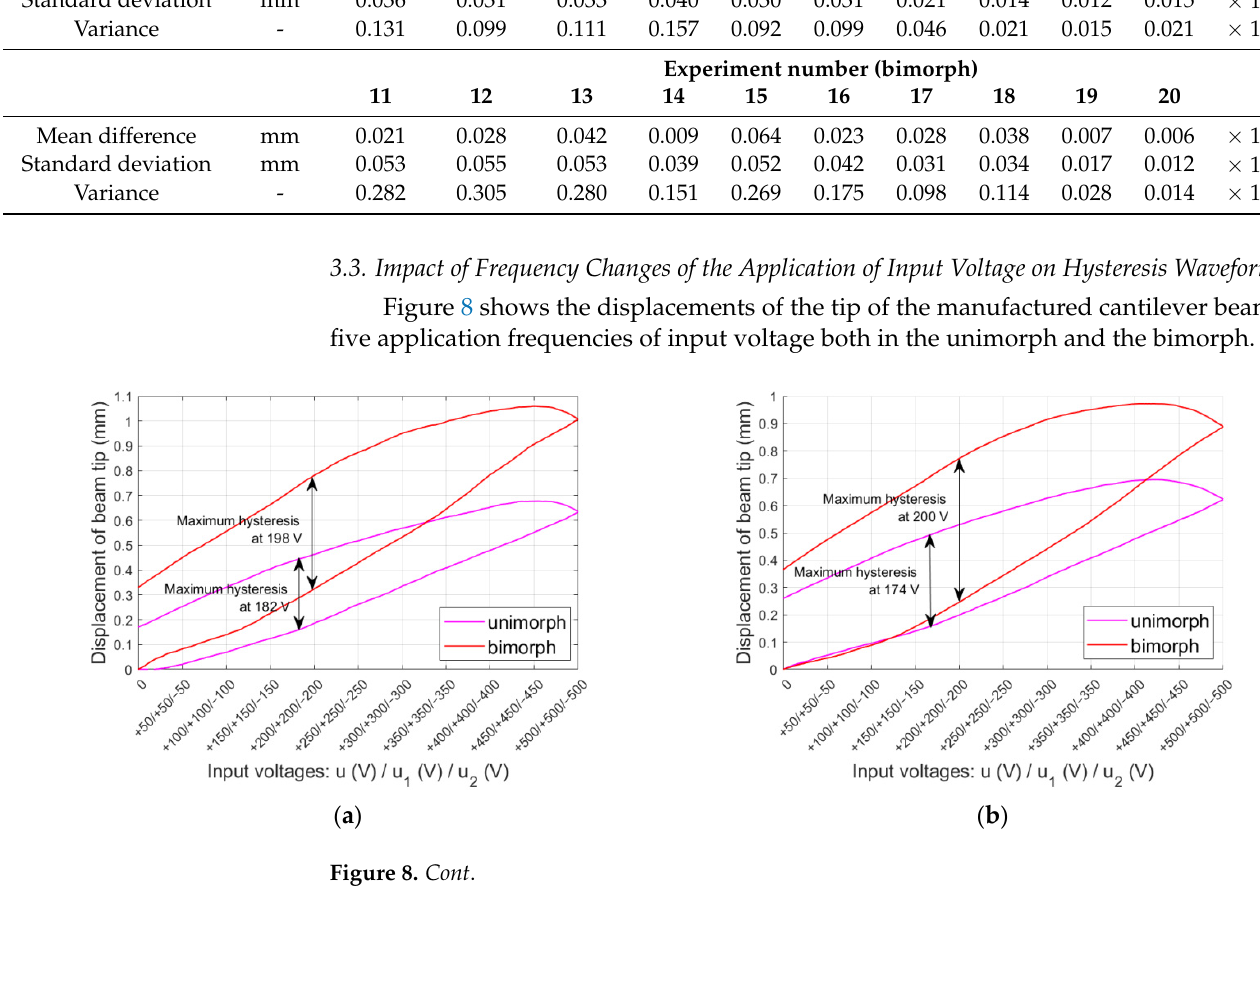
( d ) ( e ) Figure 8. Hysteresis loops in a unimorph and bimorph for u max = +500 V and u 1max = +500 V, u 2max = – 500 V: ( a ) frequency equal to 1 Hz, ( b ) frequency equal to 2 Hz, ( c ) frequency equal to 4 Hz, ( d ) frequency equal to 8 Hz, ( e ) frequency equal to 16 Hz. Comparisons of maximum hystereses for frequencies: 1 Hz, 2 Hz, 4 Hz, 8 Hz, and 16 Hz are presented in Figure 9.